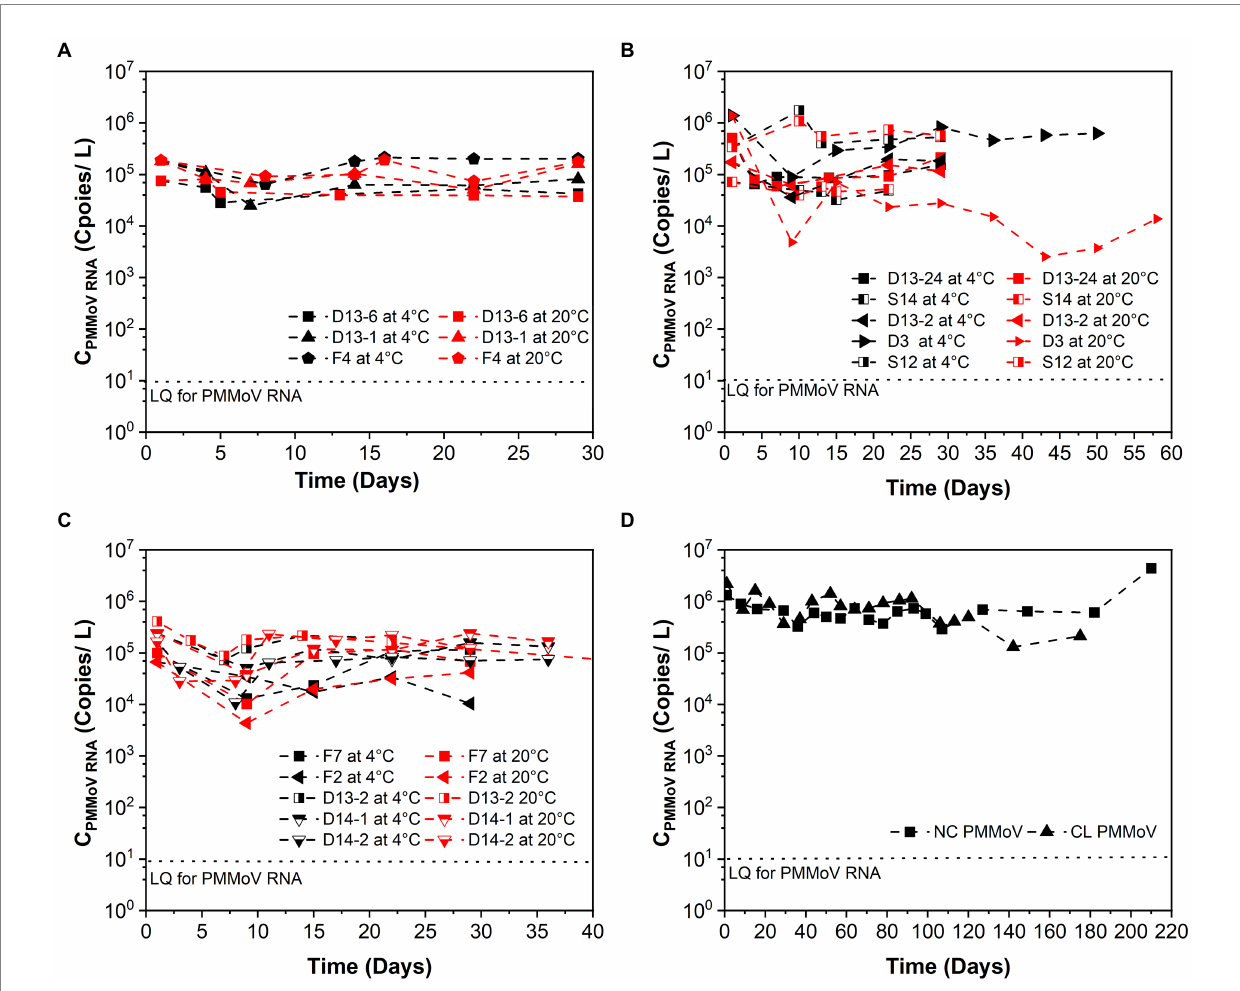
FIGURE 2 Persistence of PMMoV RNA over time (days) in raw sewage from university dormitories. (A) High-concentration level of SARS-CoV-2 (C SARS-CoV-2 RNA > 10 4 copies/L), (B) Medium-concentration level of SARS-CoV-2 (10 4 copies/L > C SARS-CoV-2 RNA > 10 3 copies/L), (C) Low-concentration level of SARS-CoV-2 (10 3 copies/L > C SARS-CoV-2 RNA > 10 2 copies/L), (D) Long time decay of SARS-CoV-2 at 4 ° C. LQ means the limit of quantification in RT-qPCR. F4, D13-6, D13-1, D13-24-1, D3, S14, D13-2-1, D13-24-2, S12-1, F7, S12-2, D13-2-2, F2, D14-1, D14-2, NC, and CL correspond to different campus